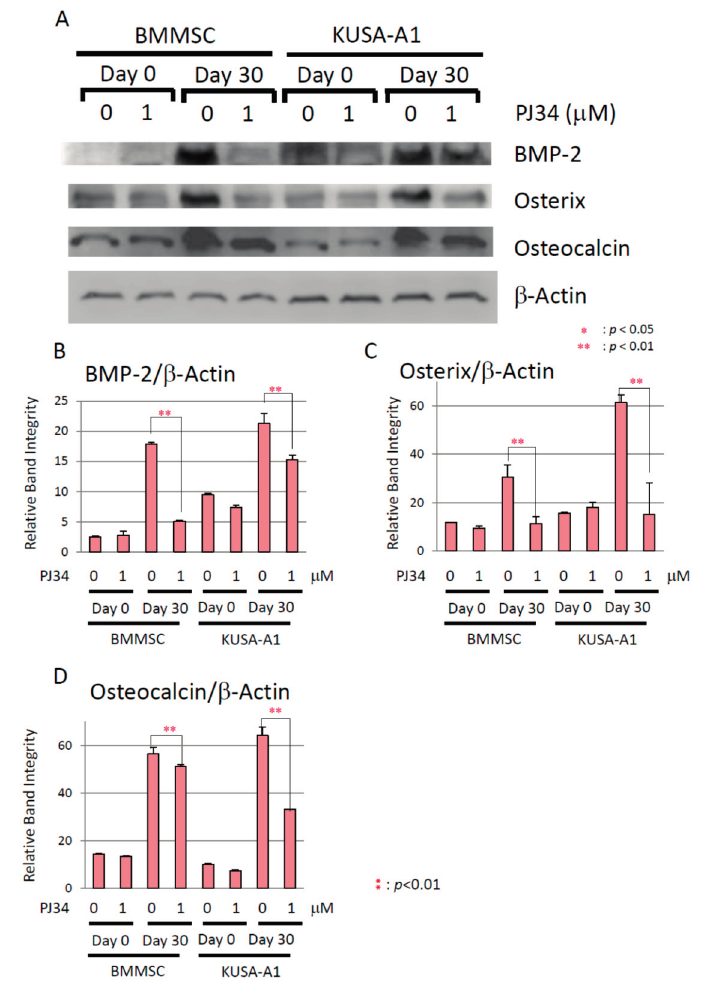
Figure 9. ( A ) The effect of PJ34 on protein levels for BMP-2 signaling pathway elements of BMMSCs and KUSA-A1 cells during osteogenic differentiation. Relative band integrity was normalized by expression level of β -Actin. The proteins analyzed were BMP-2 ( B ) Osterix ( C ) and Osteocalcin ( D ). Values are expressed as mean ± SEM., ** p <